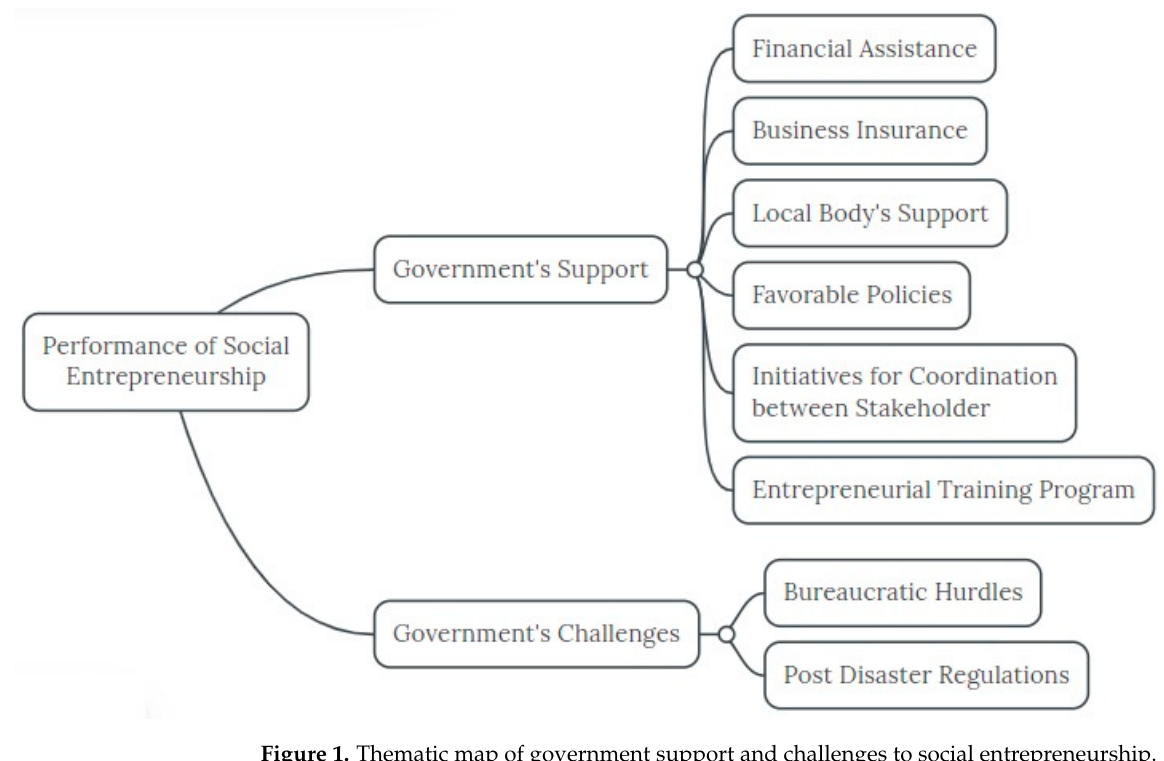
Figure 1. Thematic map of government support and challenges to social entrepreneurship.